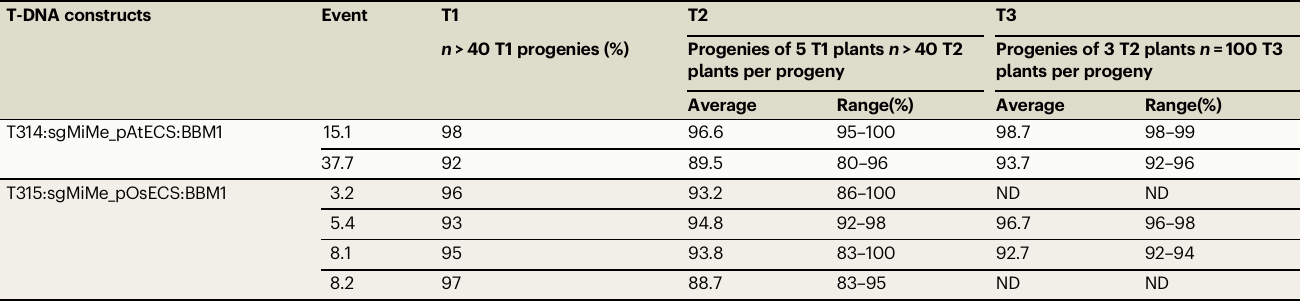
ForT2ploidydetermination,atleast40progenyplantsfrom5individualT1plants(i.e.,atleast200plantsperevent)wereanalyzed.ForT3ploidydetermination,100plantsfrom3individualT2plants (i.e., 300 plants perevent) were analyzed. Details areprovided in Supplementary Tables4 and 5. Observations at theT1 generationareprovided to facilitate interpretation ofresults. ND not diploid T1 and T2 progenies of allthe T314 andT315events ( n =765 T1s